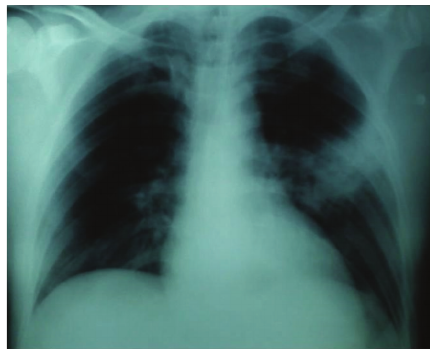
Figure 1: Chest X-ray showing left lobar consolidation.